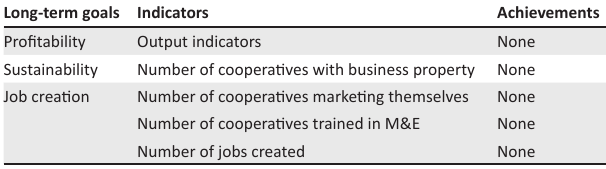
TABLE 1: Analysis of long term goals, indicators and